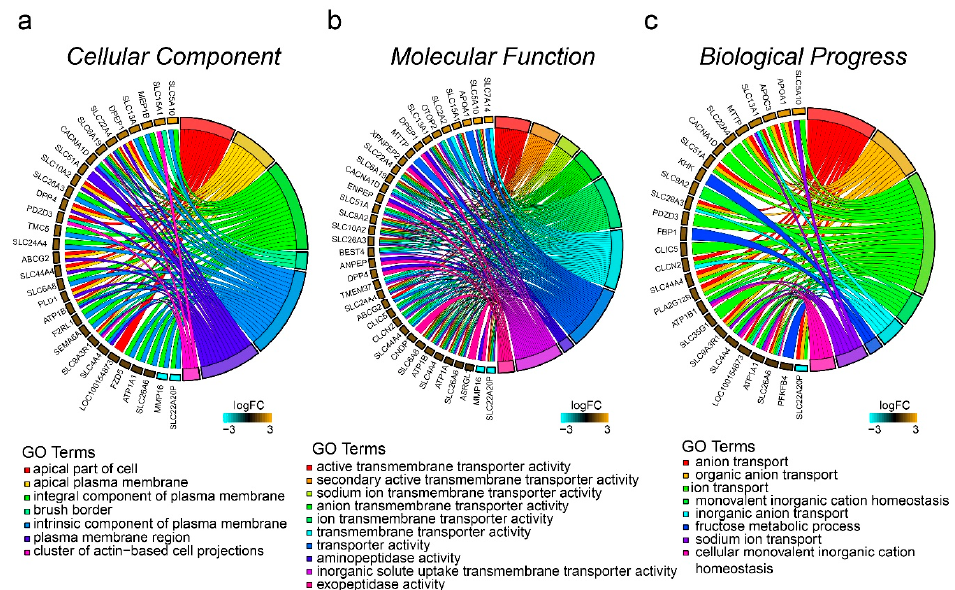
Figure 3. GOplot representation of the analysis of the gene ontology (GO) items enriched among the 433 differentially expressed genes. p -value, Benjamini-Hochberg-adjusted p -value. The left side of the circle displays the gene, and the right side shows the GO item. The assorted colors represent different GO items, and the color of each GO item is annotated below the circle. If the gene belongs to a GO item, there will be a line between the gene and the GO item. The z-score (bottom right) shows log2 (gene